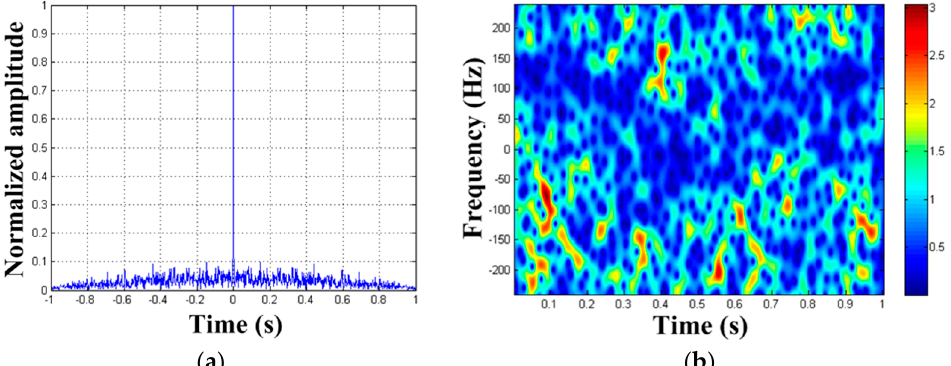
Figure 8. Detection result of x 3 ( t a ) . ( a ) Autocorrelation result of x 3 ( t a ) ; ( b ) TF distribution result of x 3 ( t a ) Table 2. Theoretical values and estimated values of the parameters. Targets Parameters Theoretical Values Estimated Values Relative Errors